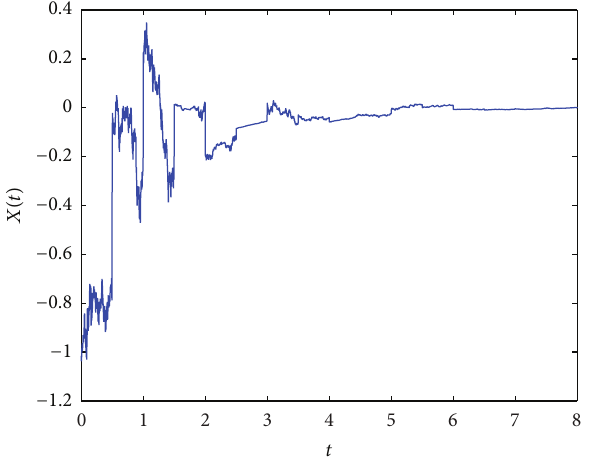
Figure 4: System with impulses for Example